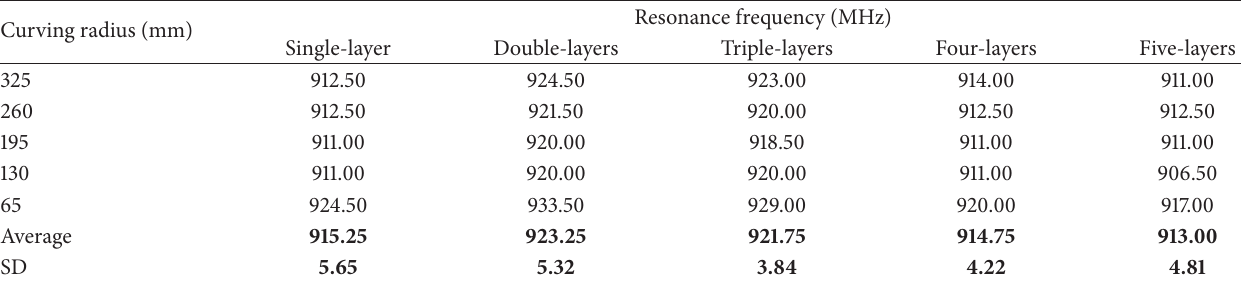
Table 3: Resonance frequency of strip dipole antenna with difference curving